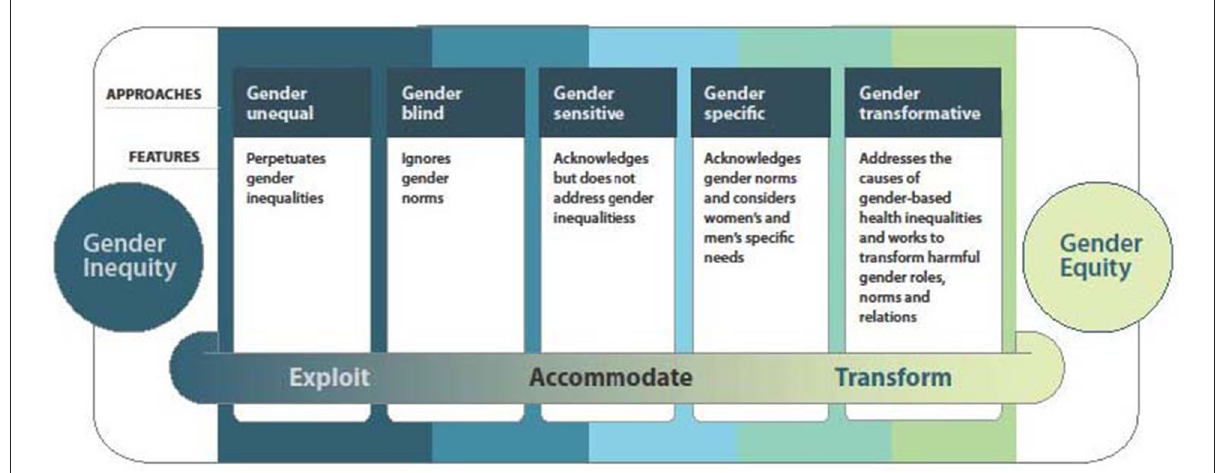
FIGURE1 A continuum of approaches to action on gender and health. Inspired by remarks by Geeta Rao Gupta, Ph.D, Director, International Center for Research on Women (ICRW) during her plenary address at the XIIIth International Aids Conference, Durban, South Africa, 12 July 2000: “To effectively address the intersection between HIV/AIDS and gender and sexuality requires that interactions should, at the very least, not reinforce damaging gender and sexual stereotypes” [see also